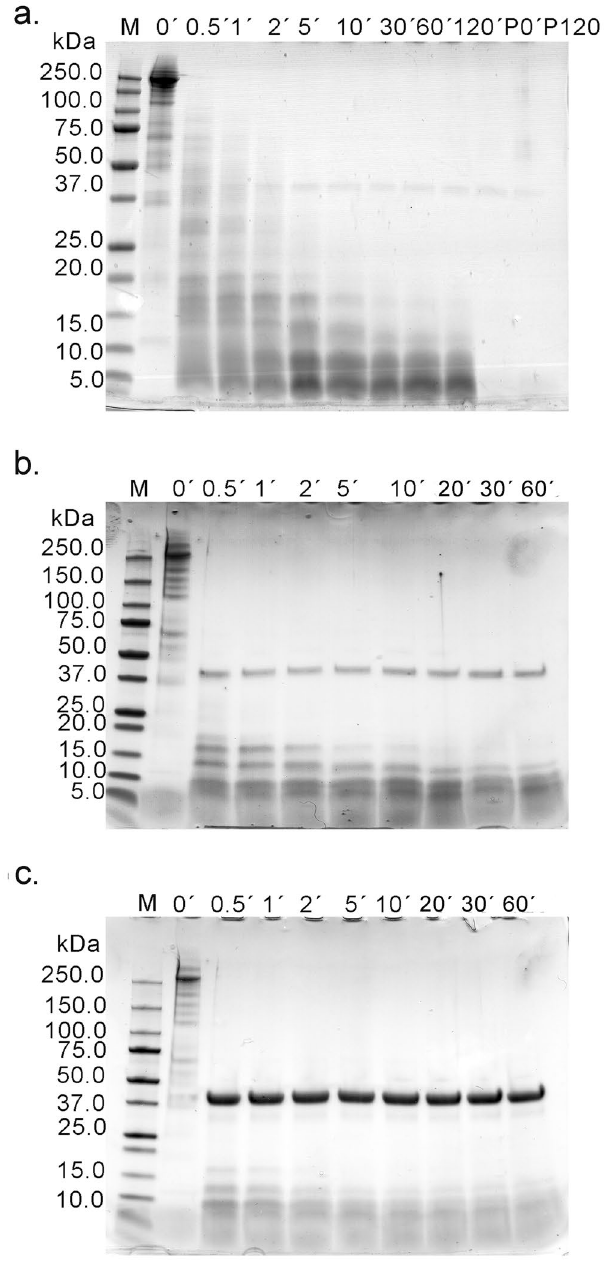
Figure 1. SDS PAGE analysis of gastric digestion of the α -Gal containing protein bovine thyroglobulin. ( a ) 0.2 U of pepsin per µ g of protein; ( b ) 1 U of pepsin per µ g of protein; ( c ) 10 U pepsin per µ g of protein. Numbers above each lane represent digestion time in minutes. P0’ and P120’ represent a control solution with pepsin only at 0 and 120